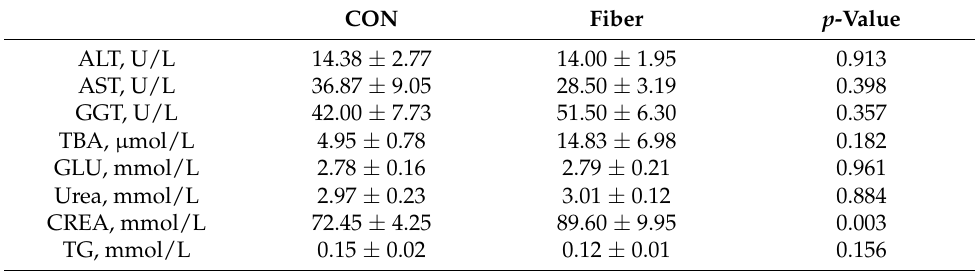
Table 3. Plasma biochemical index of newborn piglets.